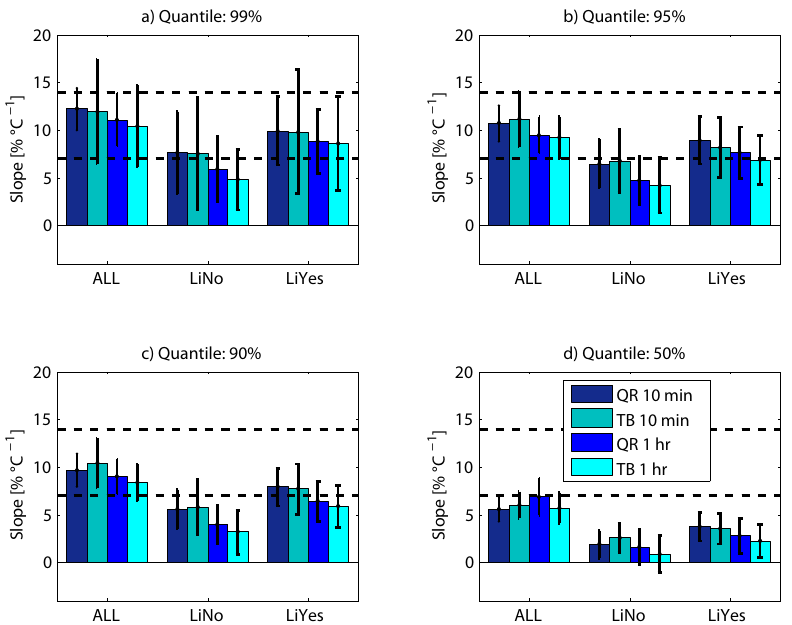
Figure 7. The mean and ± 1 standard deviation of the scaling slope estimates for mean event intensity I m for all events (ALL) consisting of lightning (LiYes) and no-lightning (LiNo) subsets for the quantile regression method (QR) and the temperature binning method (TB) and both studied resolutions 10min and 1h. Results are reported for the (a) 99th, (b) 95th, (c) 90th, and (d) 50th percentiles.